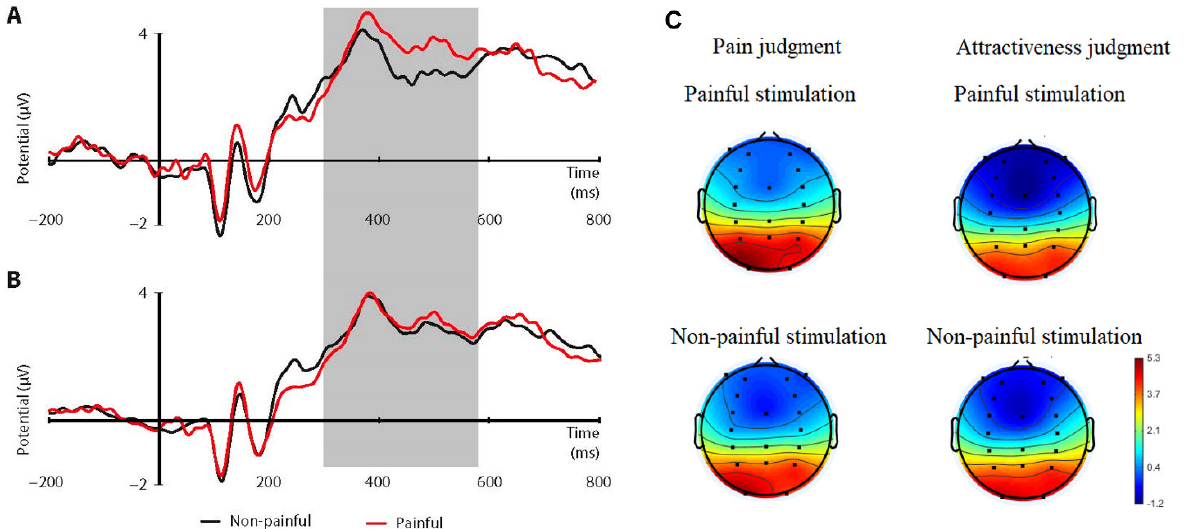
Figure 3. ( A – C ) P3 (320 ‐ 580 ms), recorded at a selection of average centro ‐ parietal electrodes relative to the two stimulation conditions (painful vs. non ‐ painful) for the pain judgment ( A ) and attractiveness judgment task ( B ). ( C ) Topographic maps of the P3 ERP component (320 ‐ 580 ms).